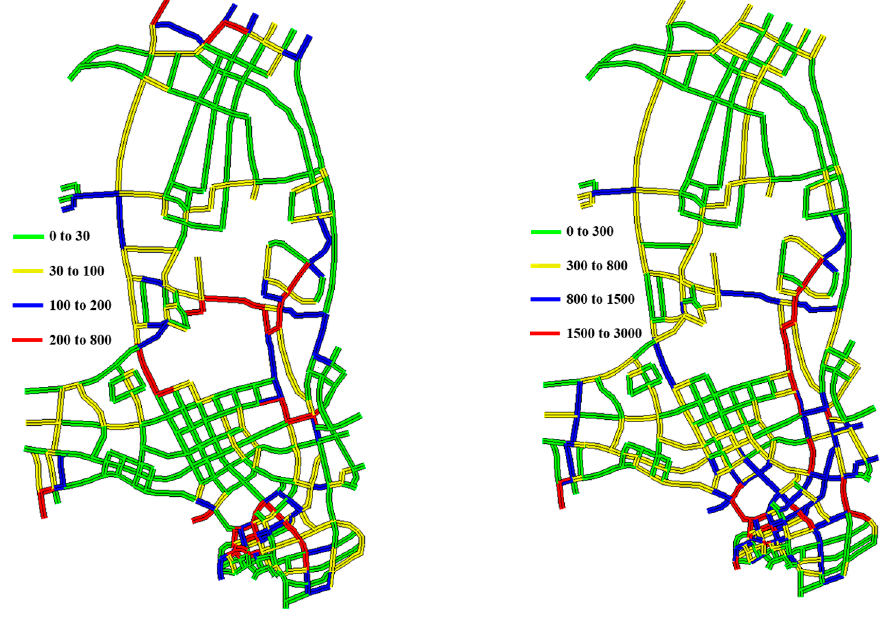
Figure 6. Assignment results in terms of traffic volume.